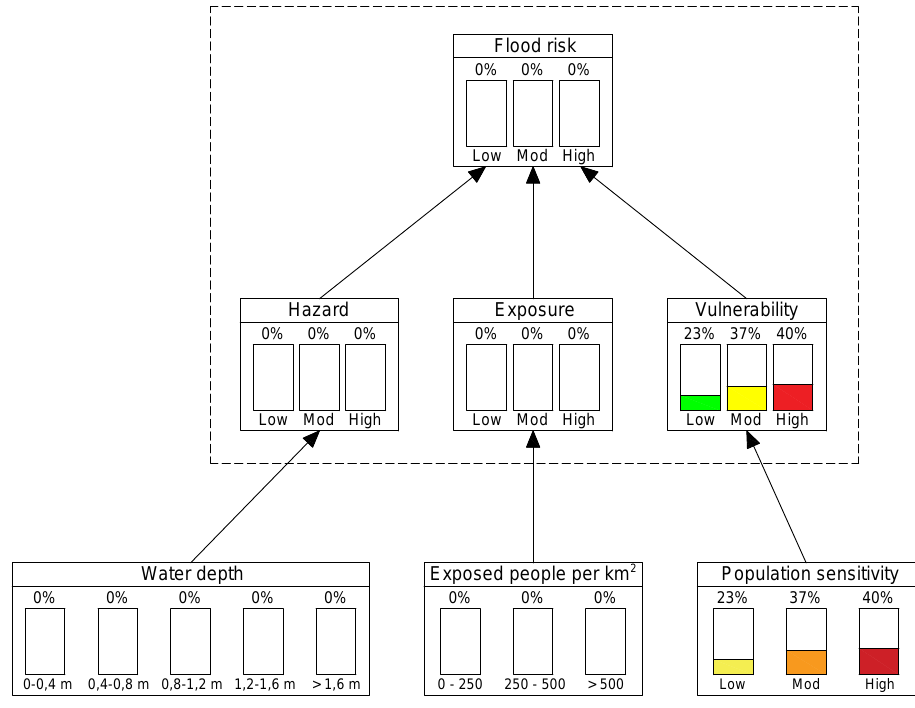
Figure 11. Bayesian network flood risk model with structural measures implemented.